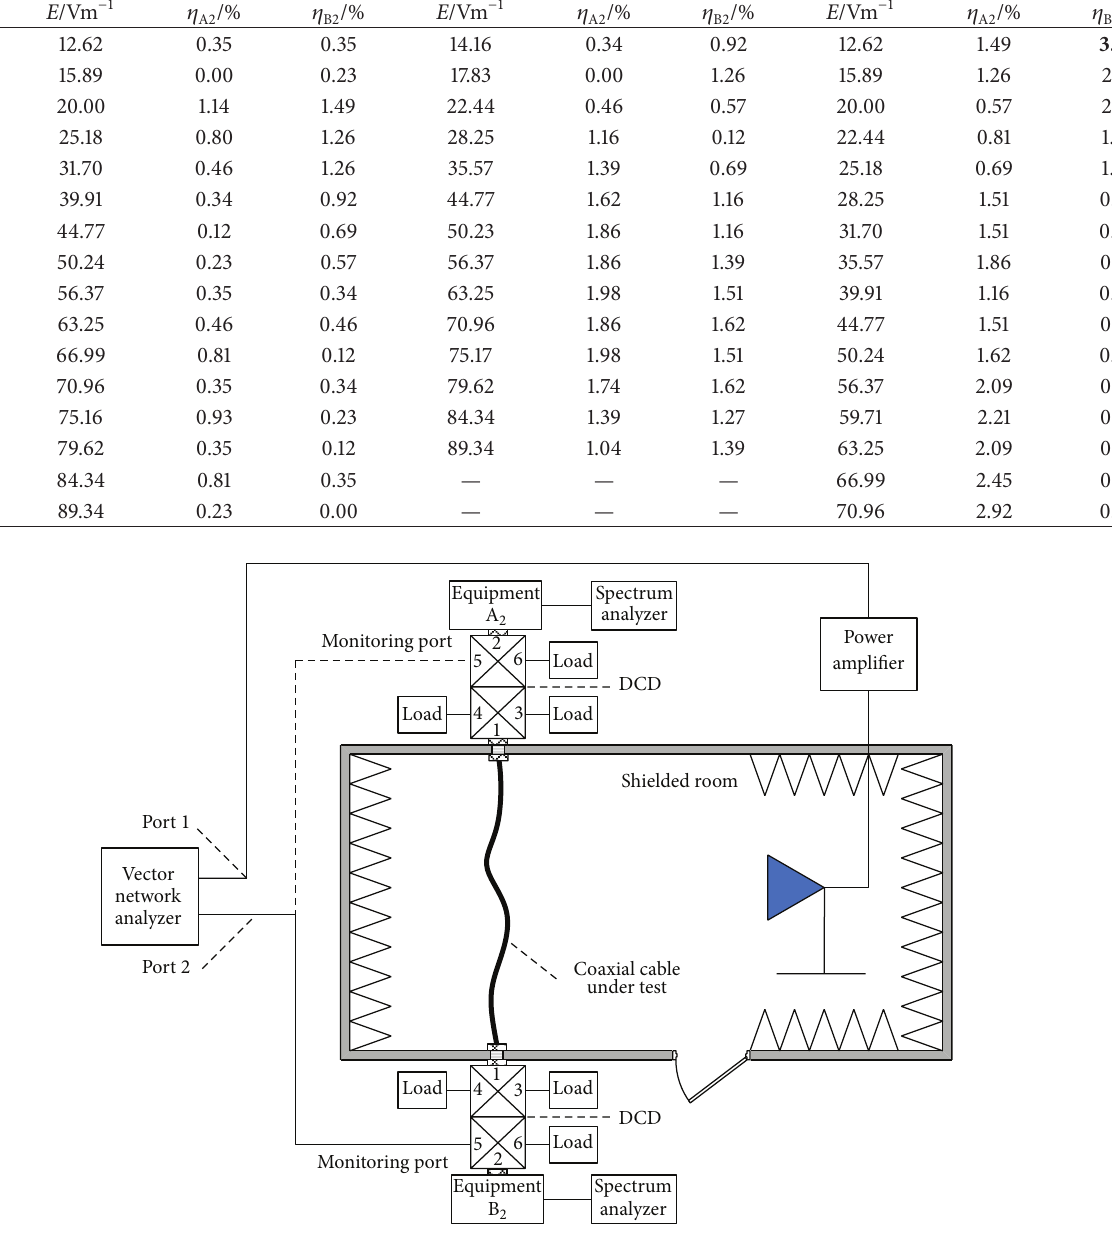
Figure 16: The configuration diagram for the radiation